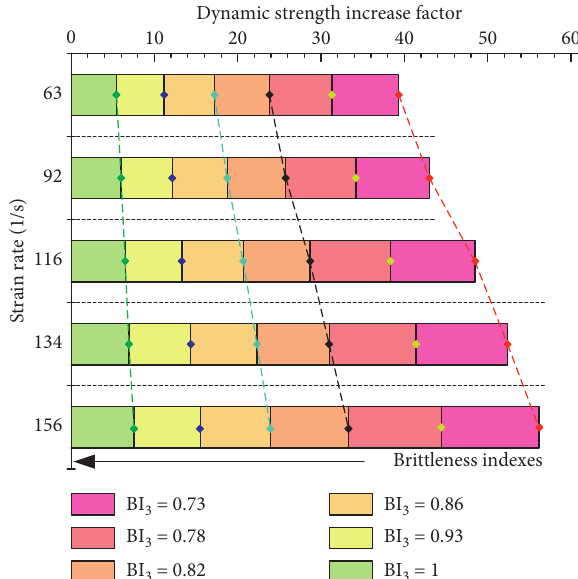
Figure 9: The evolution of dynamic strength increase factor with the brittleness and loading strain